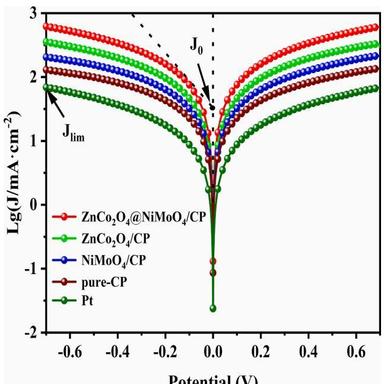
Tafel polarization characteristic curve of CEs based on different materials.